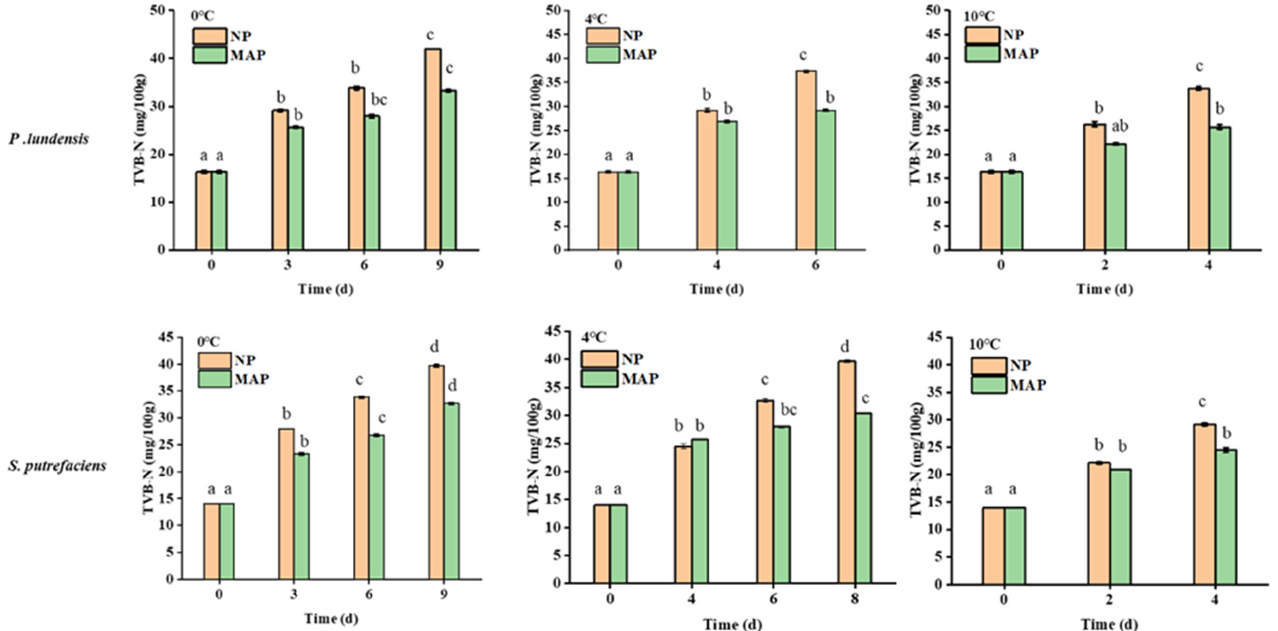
Figure 2. TVB-N content values of chicken breast samples for different treatment groups. Lowercase letters: significance of dominant spoilage bacteria at different storage times.